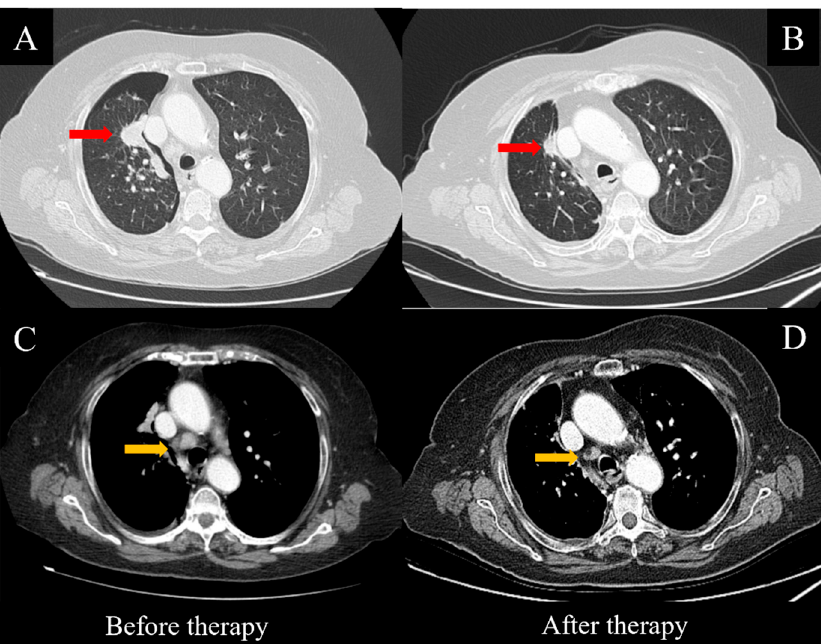
Figure 1. CT scans before and after targeted therapy with Osimertinib. Consistent regression of the main mass (red arrows, A , B ) and the mediastinal lymph nodes (yellow arrows, C , D ) was observed after eight weeks of treatment.